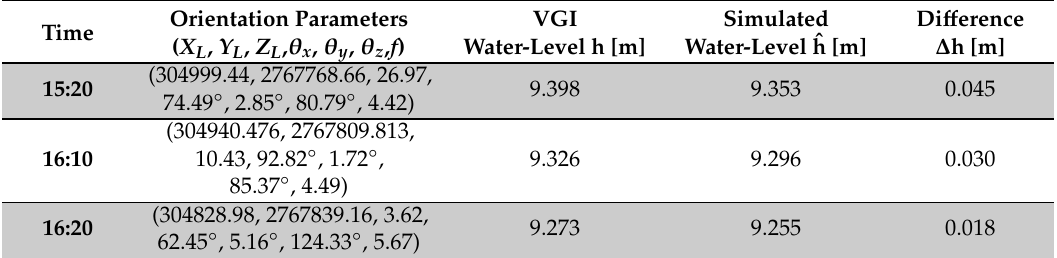
Table 4. Comparison between simulated water levels and VGI water levels determined based on the orientation parameters.